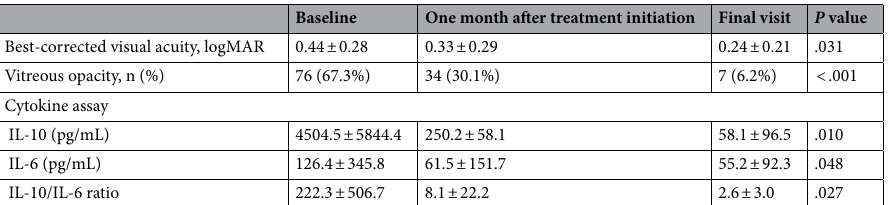
Table 4. Clinical improvement according to treatment. Data are expressed as mean ± standard deviation (95% confidence interval).